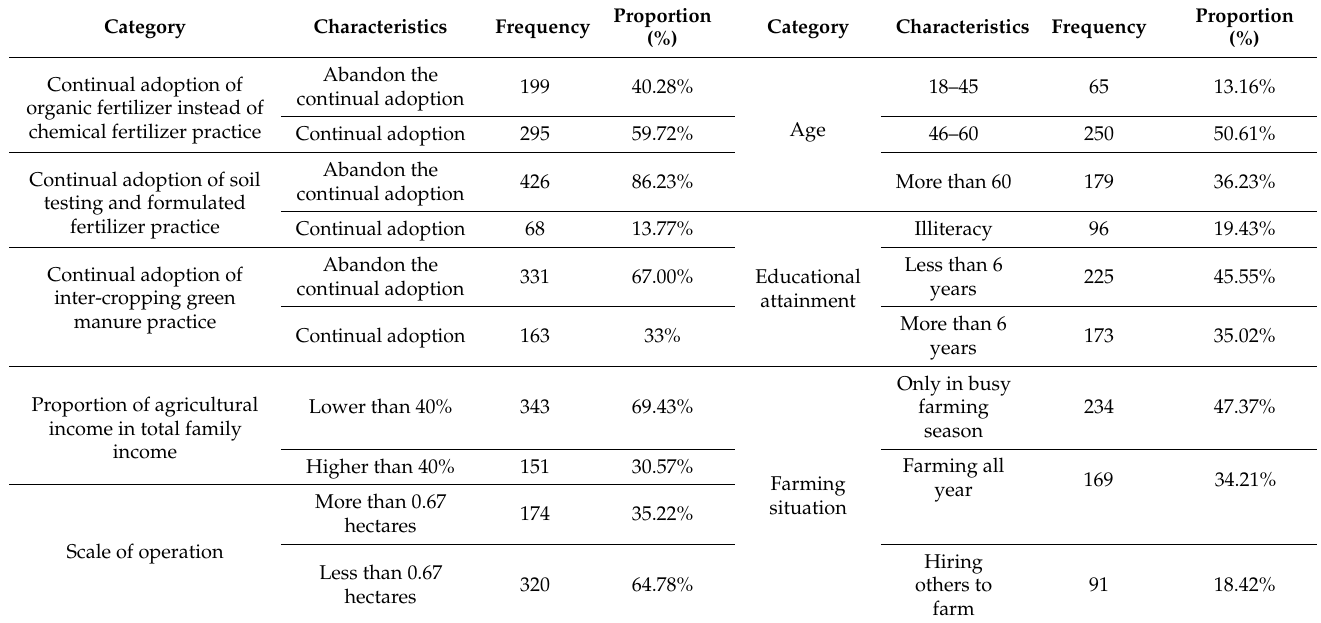
Table 5. Socio-economic and demographic profile of the